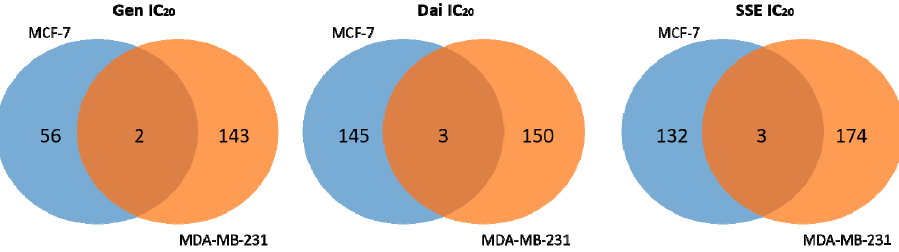
Figure 4. Venn diagram presenting the number of common and unique proteins with significantly changed abundance ( p < 0.05, FC > |2|) identified following exposure of MCF-7 and MDA-MB-231 breast cancer cells to Gen IC 20 , Dai IC 20, and SSE IC 20 , respectively.